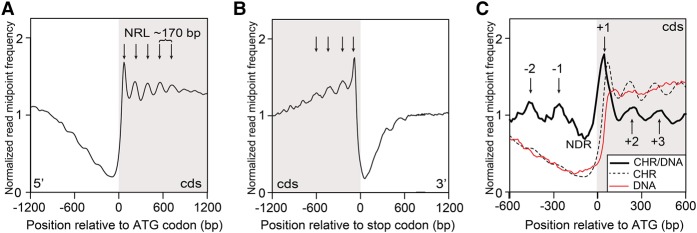
Genome-wide nucleosome positioning in Dictyostelium. (A) Normalized read midpoint frequency distributions of MNase-protected fragments (nucleosome dyads) of all 12,750 genes in growth-stage WT cells were aligned relative to their ATG codons. Peaks (arrows) correspond to dyad midpoints for globally phased nucleosomes in the 5′ region of intragenic DNA, and distances between mapped read peaks correspond to ∼170 bp NRL. The protein coding DNA sequence (cds) region is shaded. (B) Normalized read midpoint frequency distributions of all genes in growth-stage WT cells were aligned relative to their translational termination sites (stop codons). Peaks (arrows) in the mean normalized frequency distribution correspond to globally phased nucleosomes in the 3′ region of intragenic DNA. The protein cds region is shaded. (C) Normalized dyad read midpoint frequency distributions for WT chromatin (CHR; dotted line) (see A) were adjusted for sequence mappability by dividing with equivalent control data from MNase-digested naked (protein free) WT DNA (DNA; red line) and replotted as the ratio (CHR/DNA; thick black line) within 1.2 kb of flanking chromatin relative to ATG sites of all 12,750 genes. An ∼170-bp nucleosome-depleted (“free”) region (NDR) is centered near the AT-rich regions of Dictyostelium TSS. Positioned nucleosomes upstream (+) and downstream (−) to the NDR are indicated by arrows. The protein cds region is shaded.